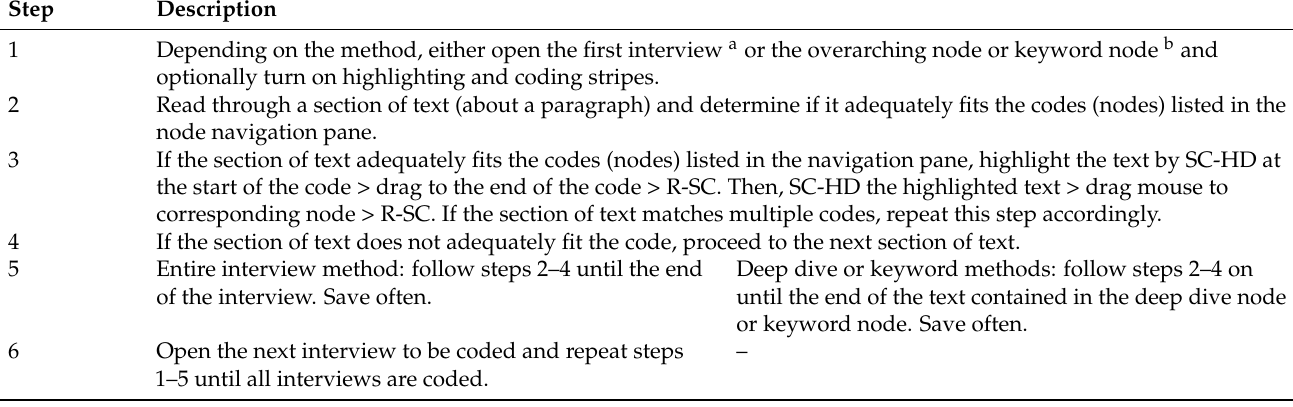
Table 3. The process of systematic